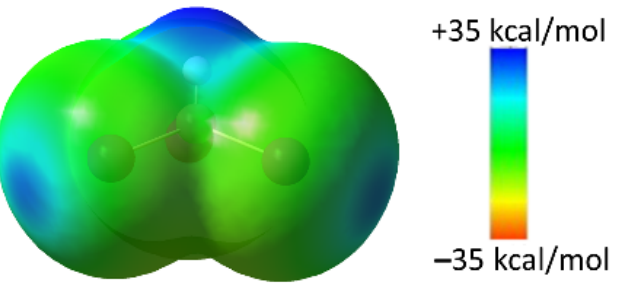
Figure 1. Surface electrostatic potential of iodoform (at 0.001 a.u. electron density) showing areas of positive potentials ( σ -holes) along the extensions of C–H and C–I bonds.